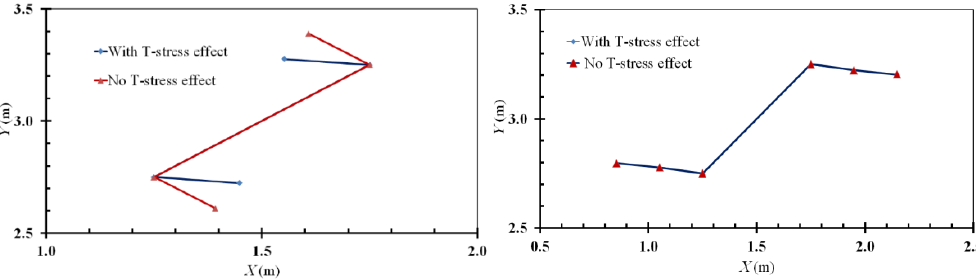
Figure 11. 45-degrees slanted center crack: under compression (left), under tension (right)